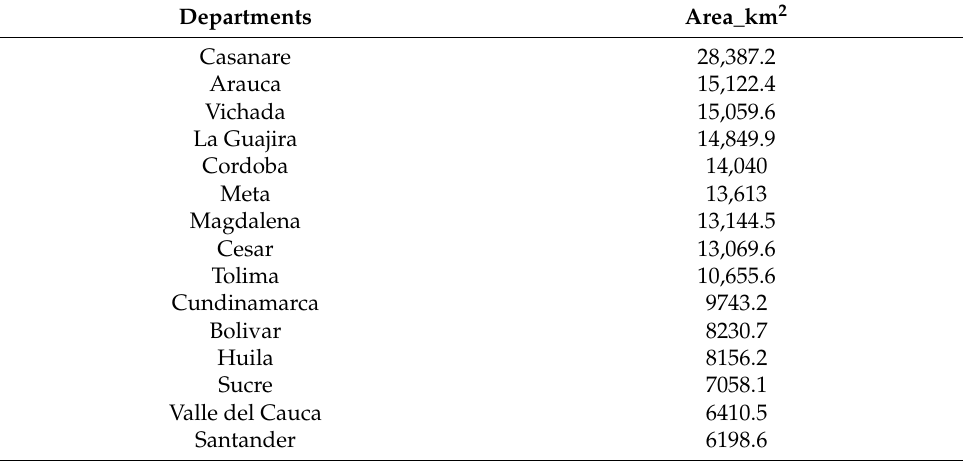
Figure 3. Base cartography for geoprocessing. Table 3. Departmental area to produce oil